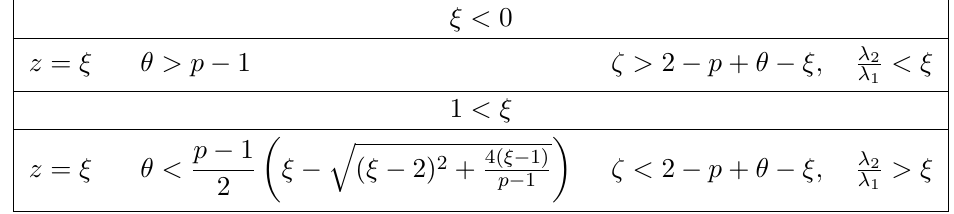
Table 9. Parameter range: Class II-i, V 0 >